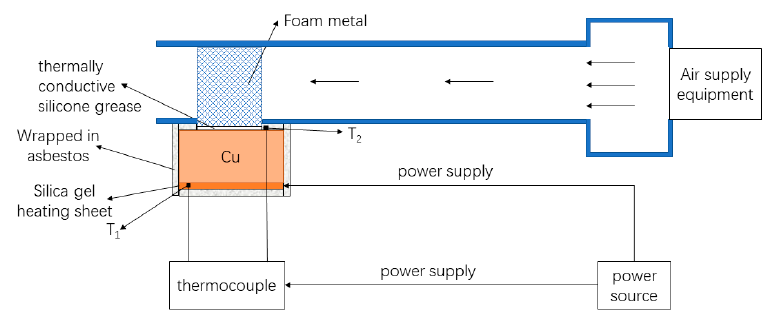
Figure 7. Forced convection cooling test setup.